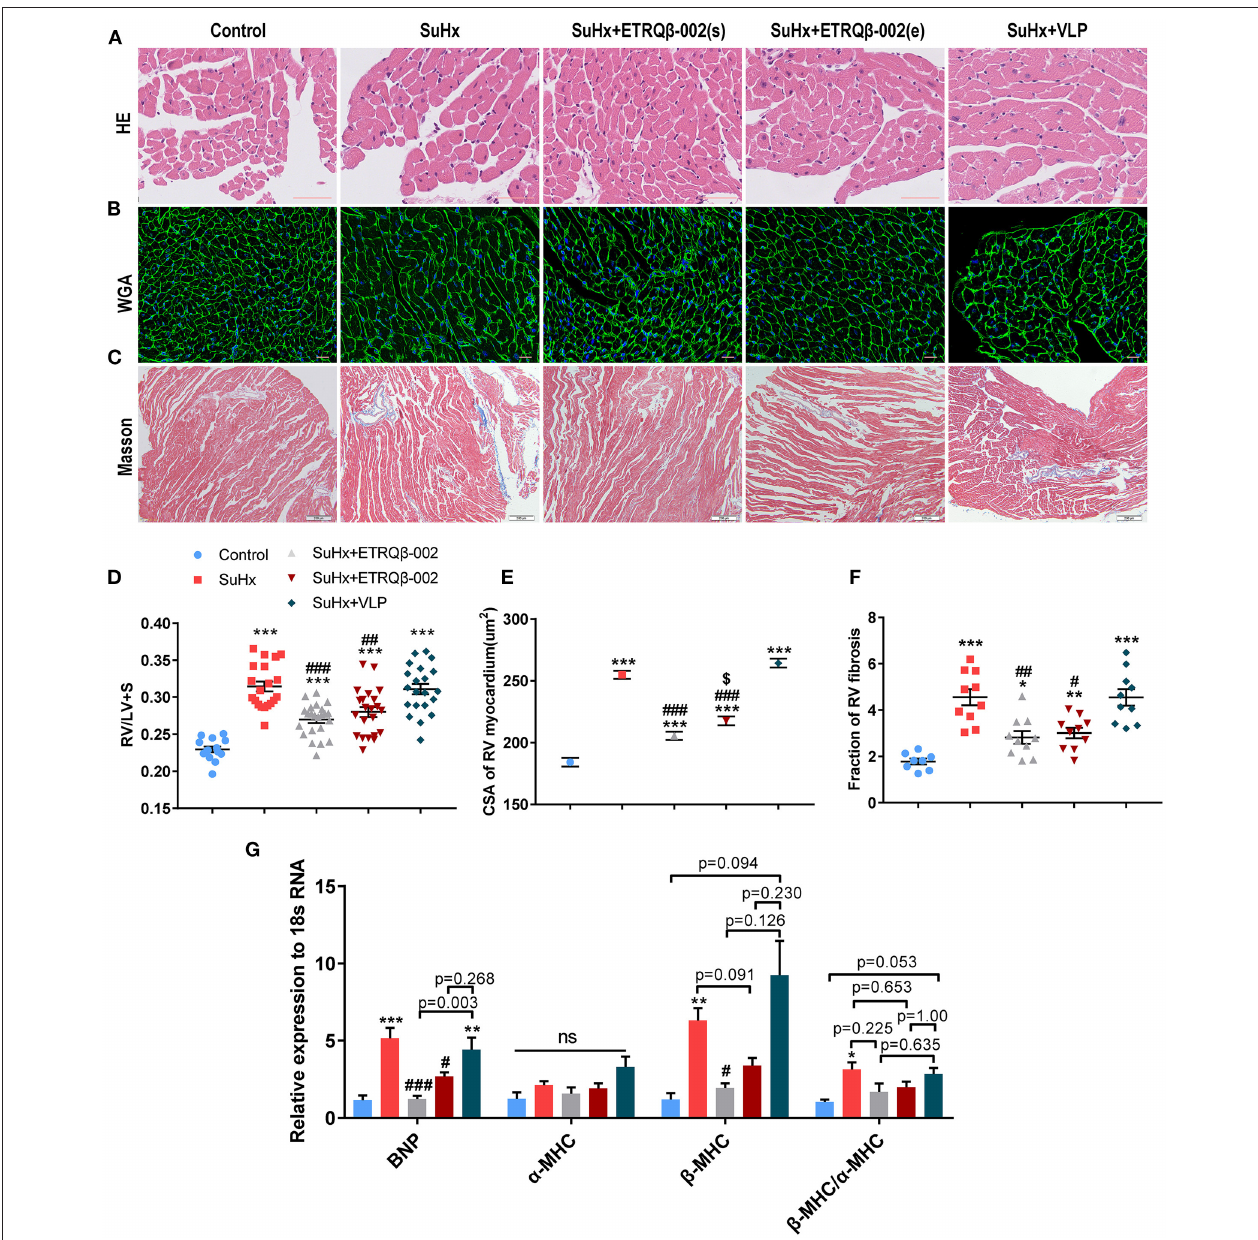
FIGURE 5 | ETRQ β -002 vaccine provided a durable effect to attenuate right ventricular pathological remodeling in SuHx-induced PAH mice. (A) The representative photographs of hematoxylin-eosin (H&E) of the RV cardiomyocytes (scale bar = 50 µ m). (B) The representative photographs of wheat germ agglutinin (WGA) of the RV cardiomyocytes (scale bar = 20 µ m). (C) The representative photographs of Masson trichrome staining of the RV (scale bar = 200 µ m). (D) The weight ratio of RV/(LV + IVS) ( n = 14–23). (E) The cross sectional area (CSA) of RV cardiomyocytes ( n = 6). (F) Percentage of RV myocardial fibrosis area ( n = 8–10). (G) Quantitative RT-PCR (qRT-PCR) analysis of ventricular remodeling gene in RVs from five groups ( n = 4–5). All data are expressed as the mean ± SEM. * P < 0.05, ** P < 0.01, *** P < 0.001 vs. the control group. # P < 0.05, ## P < 0.01, ### P < 0.001 vs. the SuHx group. $ P < 0.05 vs. the SuHx + ETRQ β -002(s) group. ns, no significant